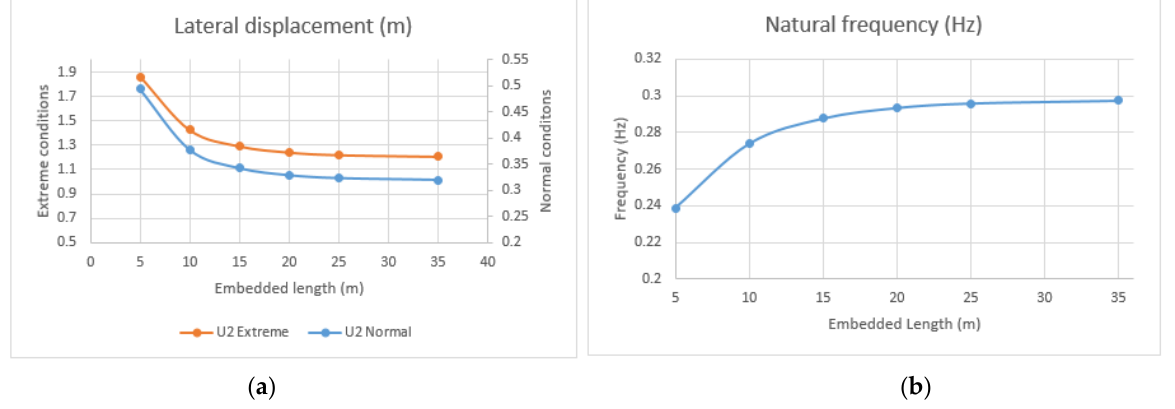
Figure 15. Influence of embedded length: ( a ) Lateral displacement, ( b ) Natural frequency.